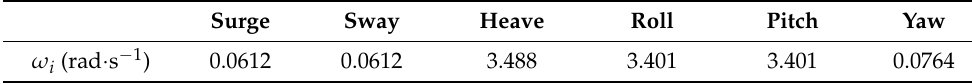
Table 1. Natural frequencies of the ISSC TLP [46]. Surge Sway Heave Roll